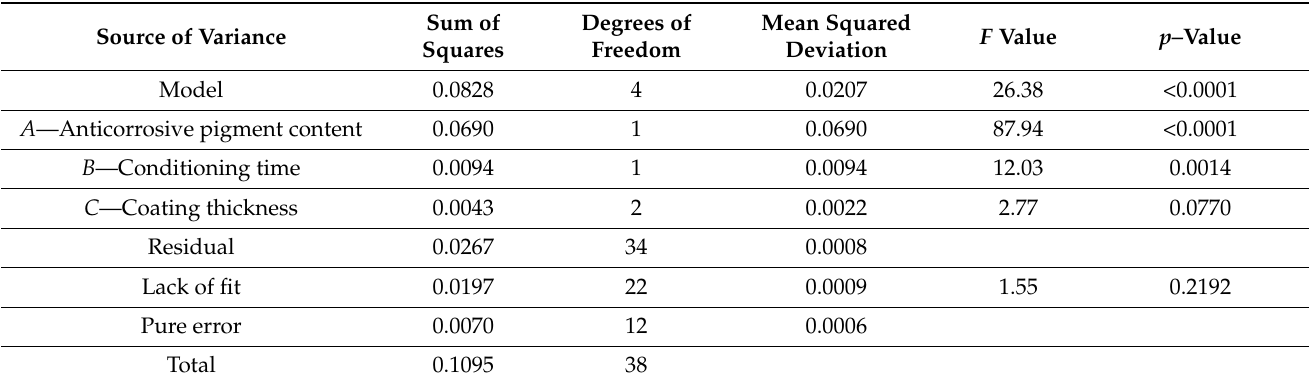
Table 7. Analysis of variance for the regression model for notch corrosion after 240 h in the salt-spray test